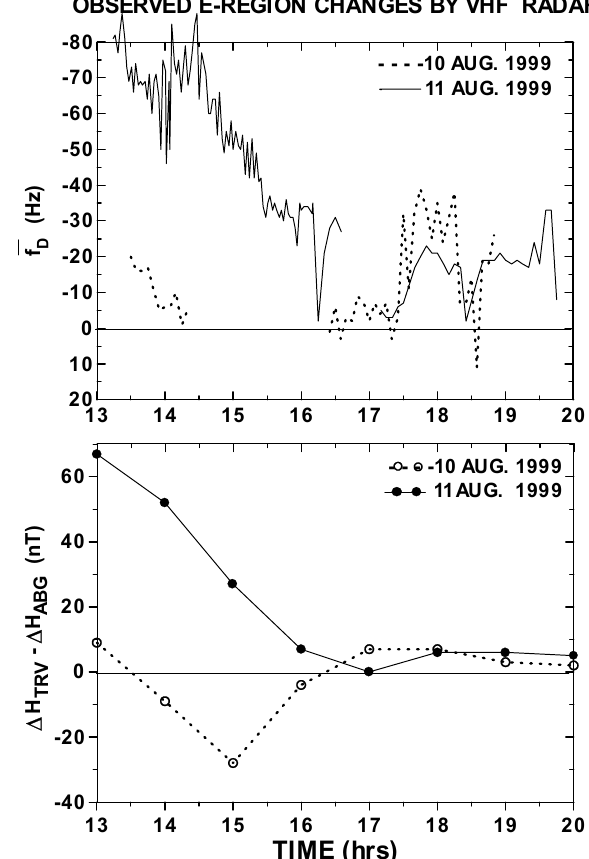
Fig. 2. The variation of the mean Doppler frequency ( f D ) as ob- served by the VHF backscatter radar corresponding to the height re- gion of 104km over the magnetic equator at Trivandrum (top panel) and the intensity of the electrojet given as 1H TRV − 1H ABG (bot- tom panel) corresponding to the 10 and 11 August 1999. Negative values of f D correspond to eastward electric